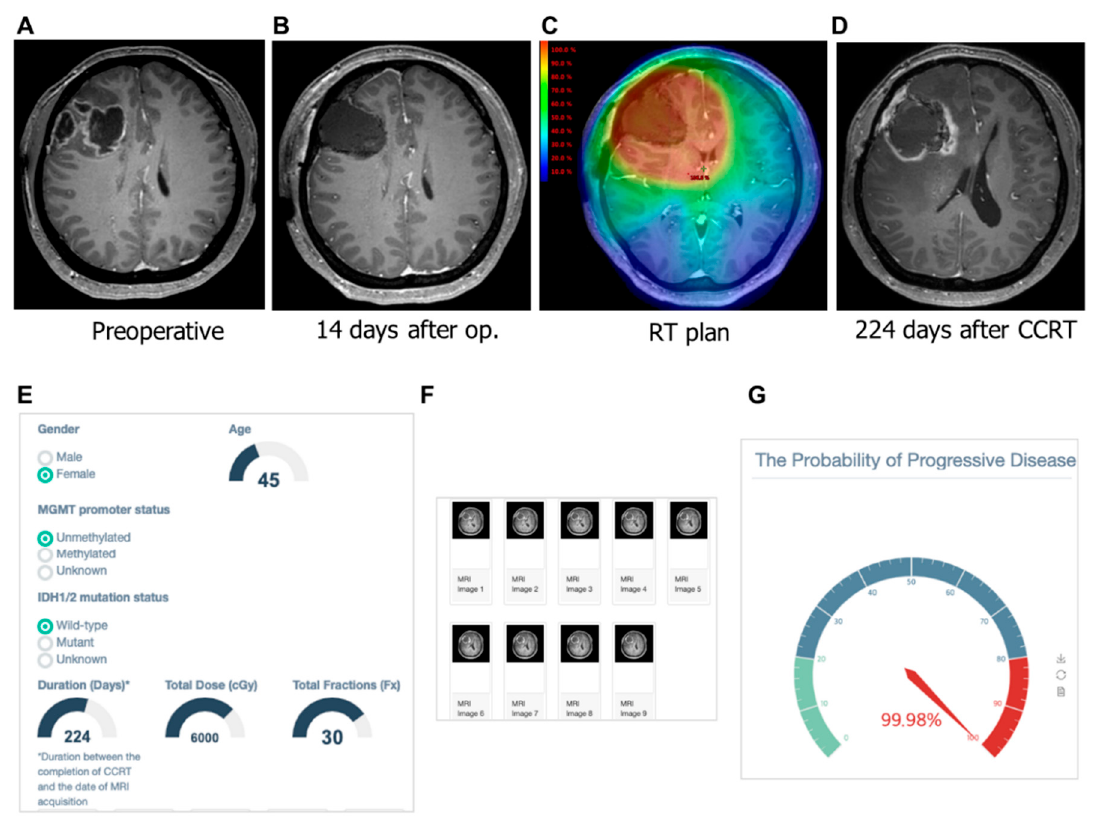
Figure 6. Gadolinium-enhanced T1-weighted magnetic resonance (MR) images from a 67-year-old woman with glioblastoma and the clinical application of machine learning model. ( A ) Pre-operative MR image showing an enhanced lesion. ( B ) No residual enhancing lesion in the cavity after the gross total resection. ( C ) Radiation therapy plan image showing the isodose line. ( D ) Hemorrhagic lesion as well as enhancing lesion appeared in resection cavity within the 80% isodose line after the completion of concurrent chemoradiation. ( E ) The screenshot of clinical information is given to a web platform. ( F ) Nine MR images are selected and uploaded to the platform. ( G ) Gauge figure representing the probability of progressive disease. This patient underwent a re-operation for bleeding control and resection. Pathologically, the enhancing lesion was recurrent glioblastoma.